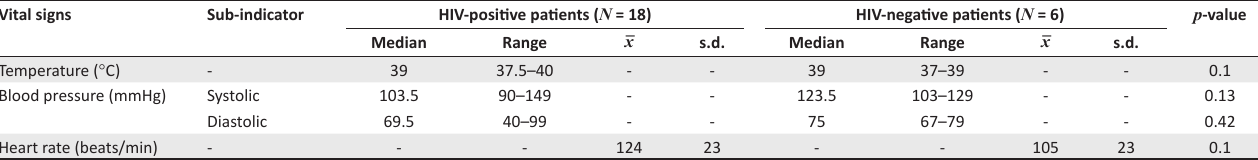
TABLE 2A: Examination findings in 24 adult patients with measles: Comparison of HIV-positive and HIV-negative cases. Vital signs